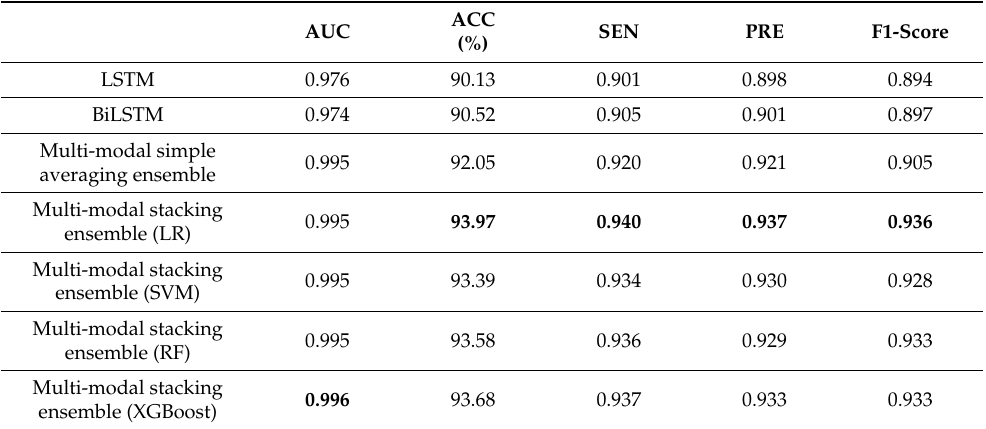
Table 5. Diagnostic performance of LSTM, BiLSTM, multi-modal simple averaging ensemble, and multi-modal stacking ensemble